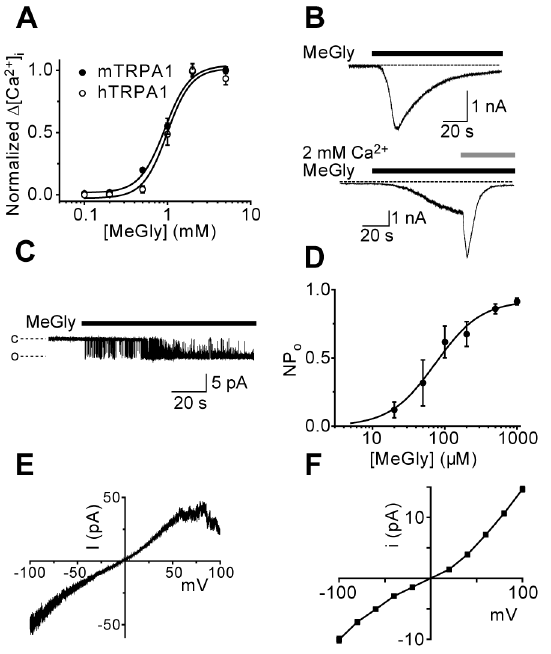
Figure 1. Methylglyoxal is an intracellular TRPA1 agonist. (A) Application of MG evokes concentration-dependent [Ca 2 + ] i -responses in CHO cells expressing mouse or human TRPA1. (B) MG (0.5 mM) elicits inward currents with the characteristic rapid onset and inactivation in the presence of 2 mM Ca 2 + (top panel). In Ca 2 + -free solutions (1 mM EGTA) the inward current grew more slowly and addition of Ca 2 + produced the typical current surge followed by a rapid inactivation of the current (bottom panel). (C) MG rapidly activates TRPA1 in excised inside-out patches, with a markedly higher potency than when applied extracellularly (D, compare with A). (E) The current voltage relationship in membrane patches containing several channels demonstrated a reversal potential close to 0 mV and channel block or inactivation at positive membrane potential. (F) Current-voltage relationship for a single channel in an inside-out patch stimulated with